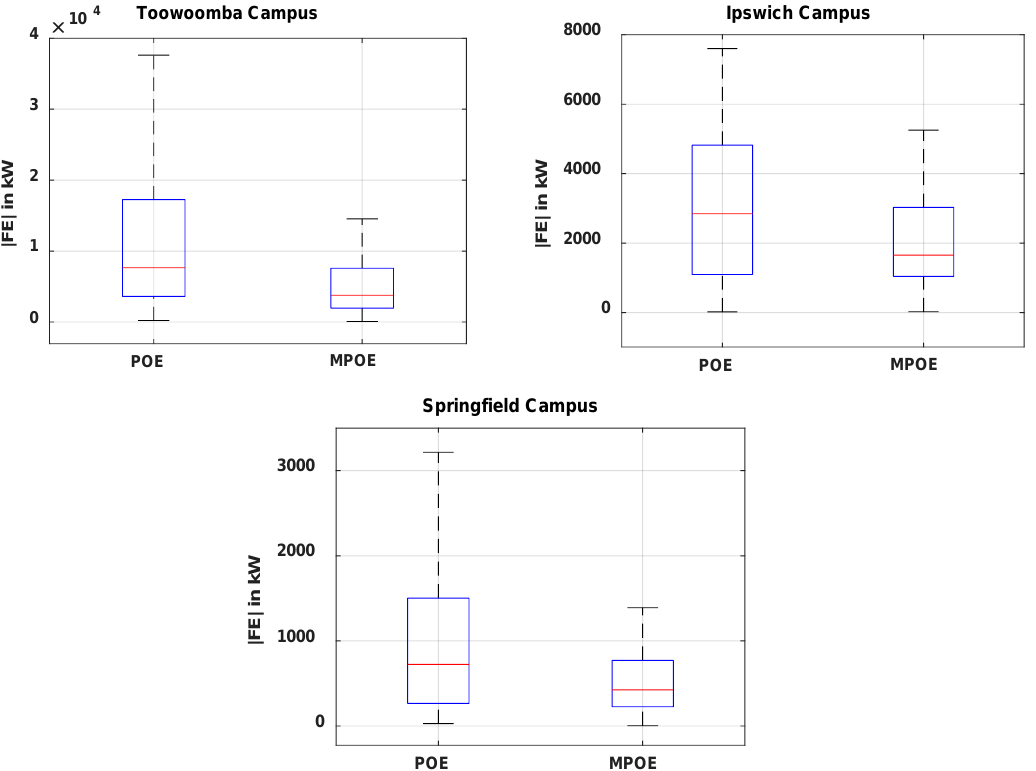
Figure 7. Boxplots of the absolute forecasted error | FE | in the testing dataset for the three study sites with the optimal models of POE and MPOE.